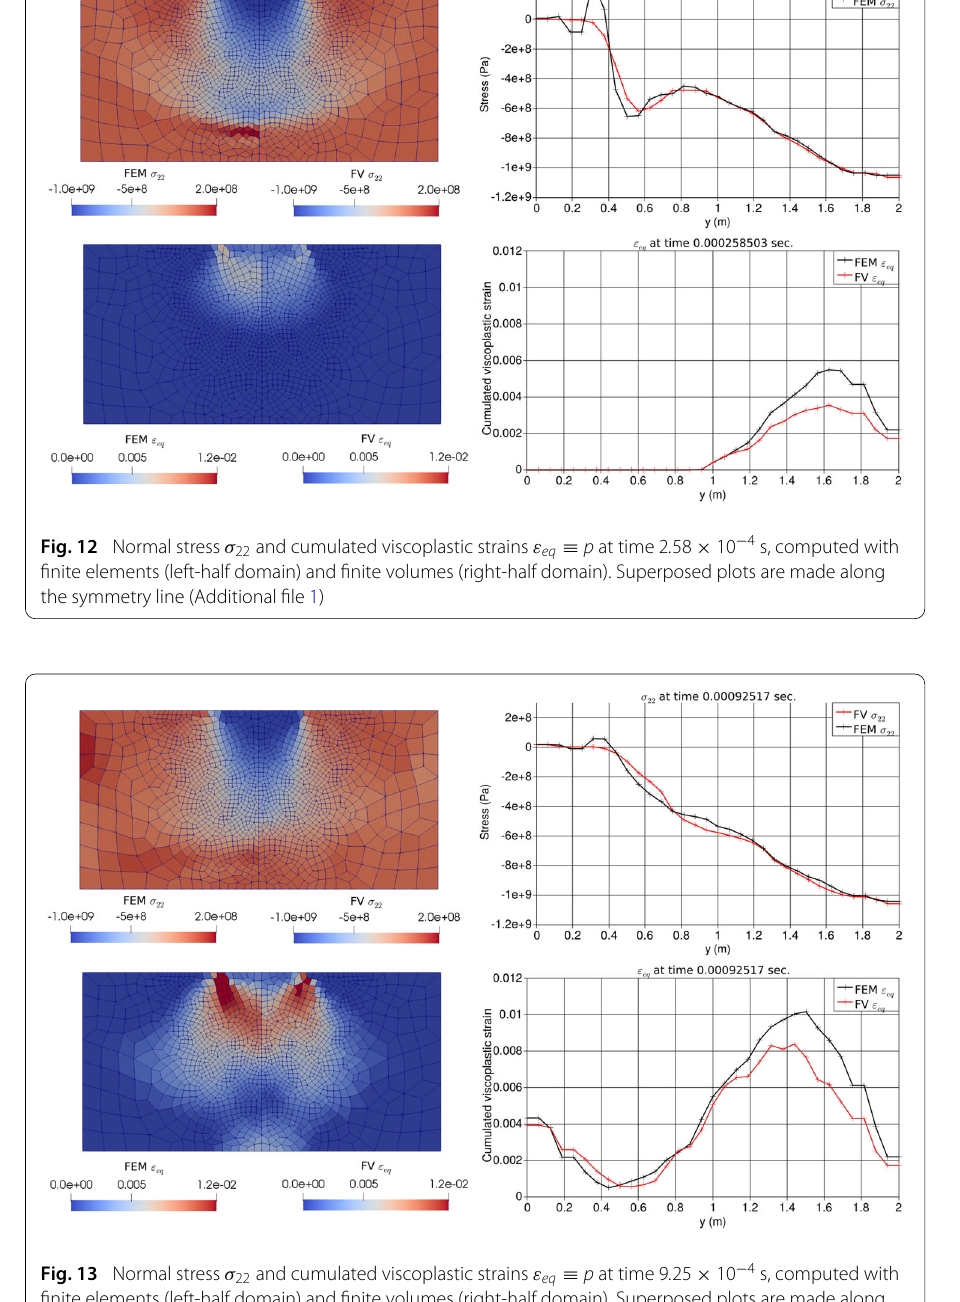
from that area. Second, the free boundary defined at the bottom face has led to convert the initial pressure wave into a tensile one after reflection, which has generated viscoplastic strains close to that bottom face. Again, finite element and finite volume solutions look close up to few details here and there on stress and cumulated viscoplastic strains